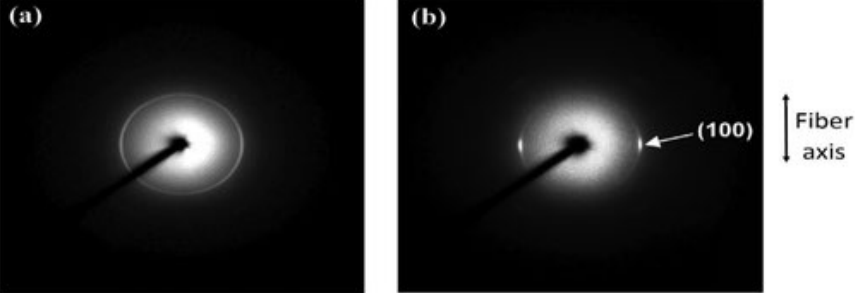
Figure 28. Two-dimensional WAXD patterns for (100) reflection of aligned polyoxymethylene nanofibers at different take-up velocities: ( a ) 630 m/min and ( b ) 1890 m/min. Reproduced from [182] with permission of the American Chemical Society.